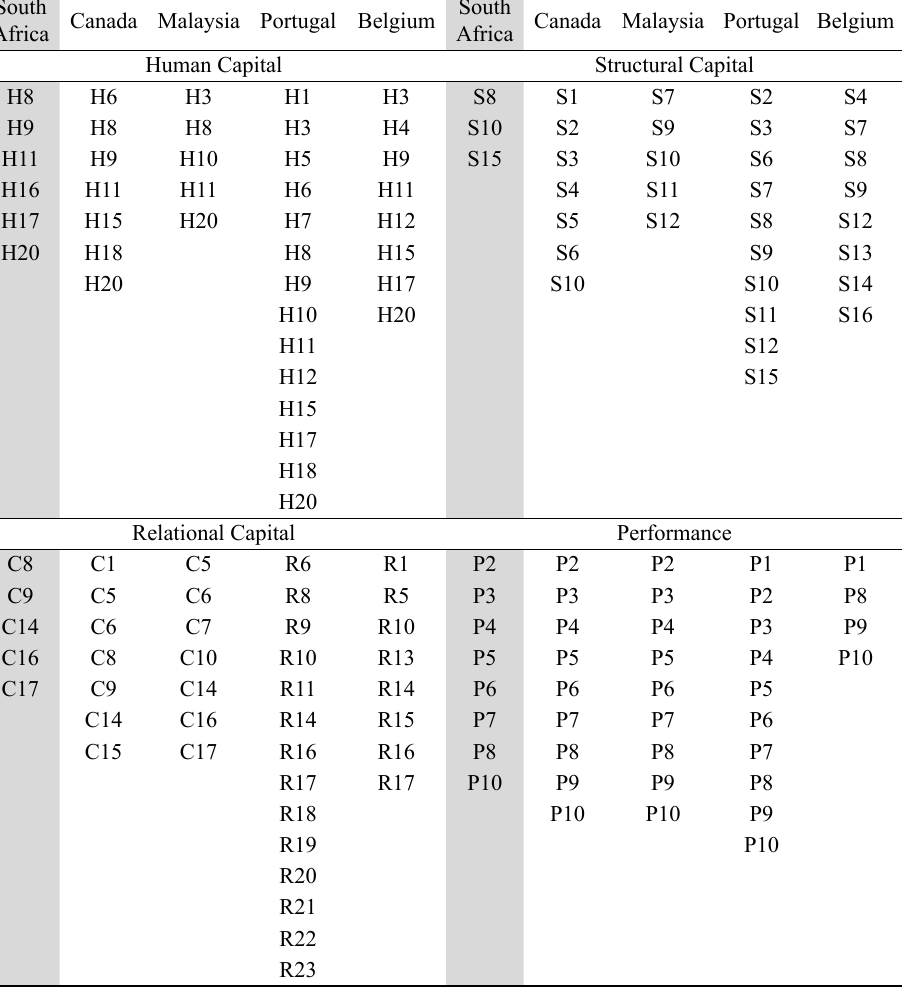
Table 1. Constructs: final data set and country comparisons South